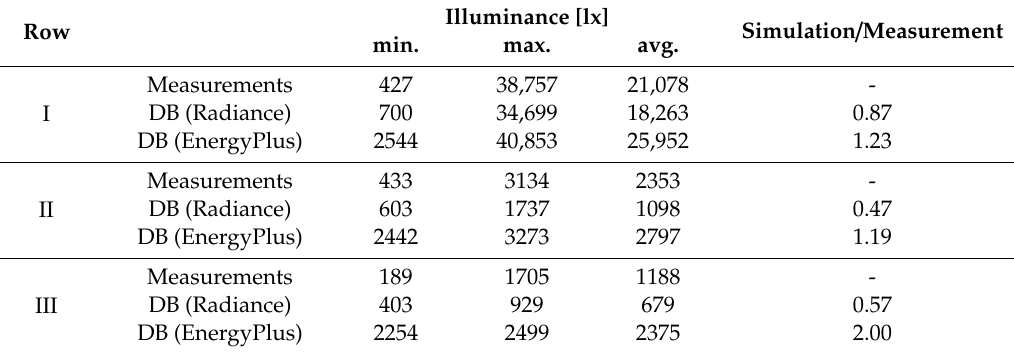
Table 3. Illuminance values summary for sunny conditions (21 September